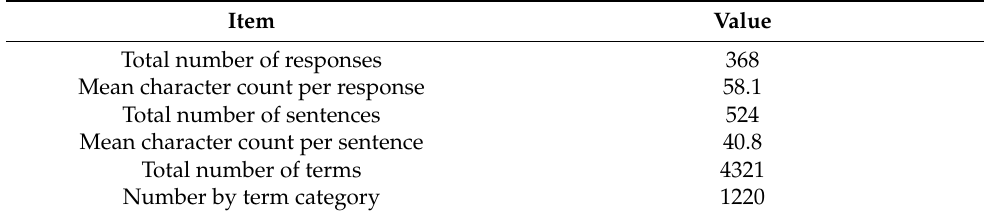
Table 4. Sentence composition of text data in the open-ended